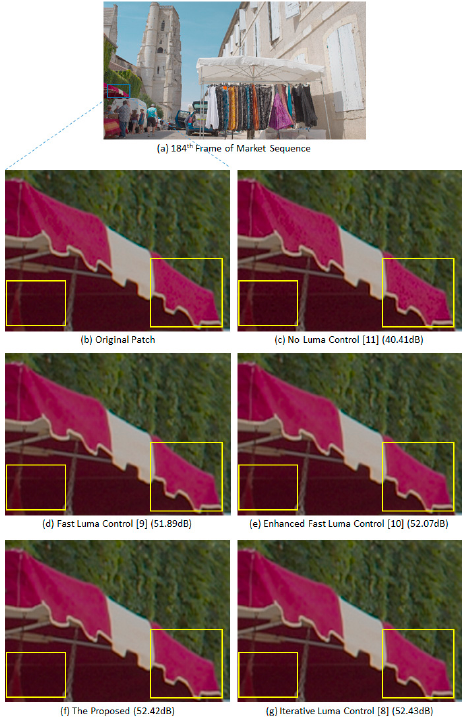
Figure A1. The visual effect comparison for the test sequence “Market” (184th frame). The number in parentheses for each subfigure means the tPSNR-Y value of the image patch produced by each luma control algorithm.